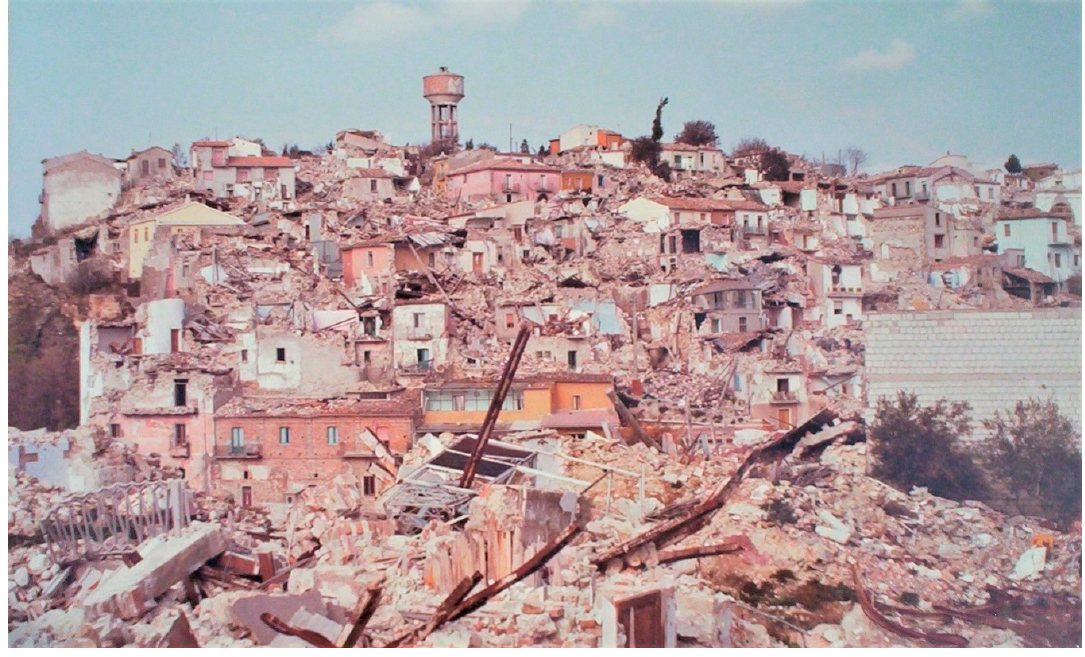
Figure 2. Effects of the earthquake in Conza della Campania (Courtesy of Pro Loco Compsa). Figure 2. E ff ects of the earthquake in Conza della Campania (Courtesy of Pro Loco Compsa). Geosciences 2020 , 10 , x FOR PEER REVIEW